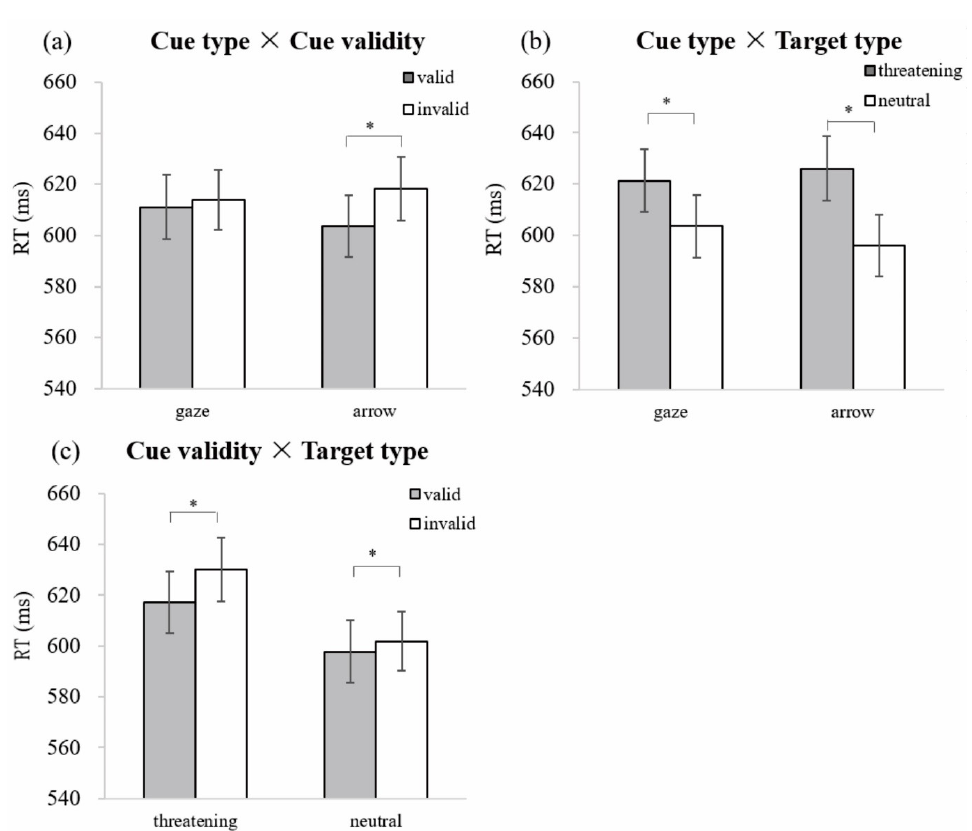
Figure 3. Mean RTs and standard errors for the interactions of ( a ) Cue type and Cue validity; ( b ) Cue type and Target type; ( c ) Cue validity and Target type. * p < 0.05. Error bar represents standard error.